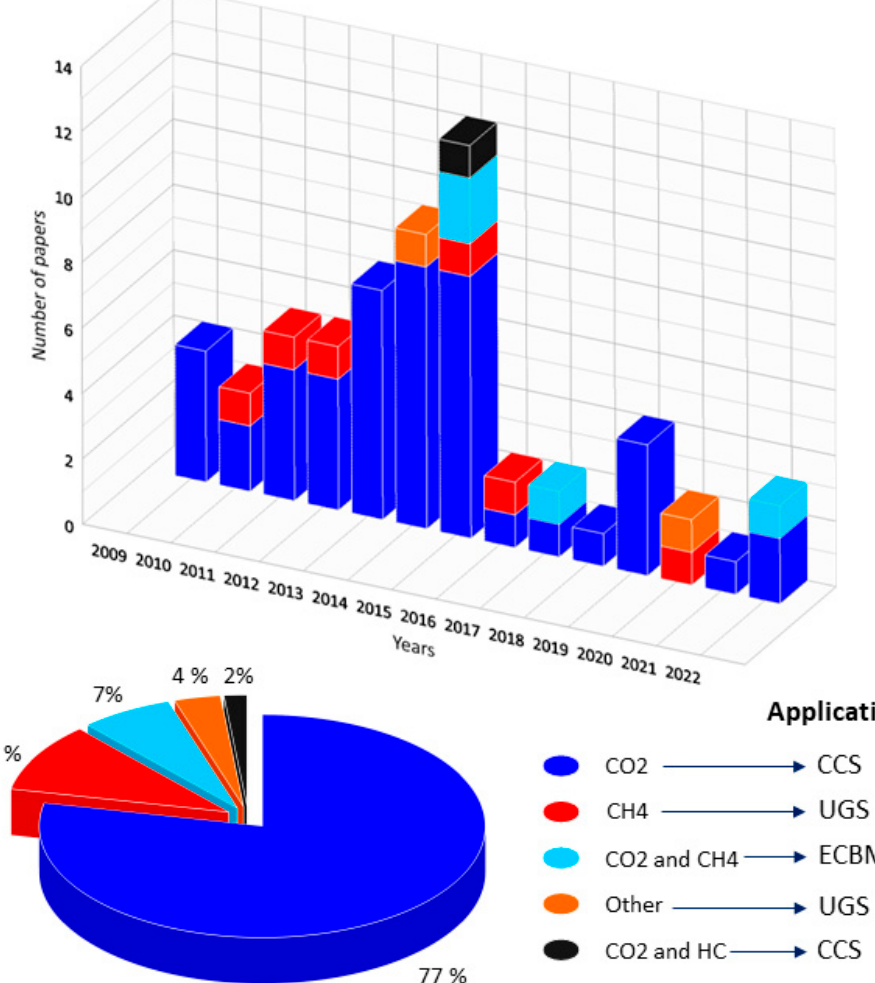
Figure 6. Scientific papers published from 2009 to 2022 subdivided for gas analysis and different storage activities. In the bottom left: the statistical percentage of gas used for different applications.